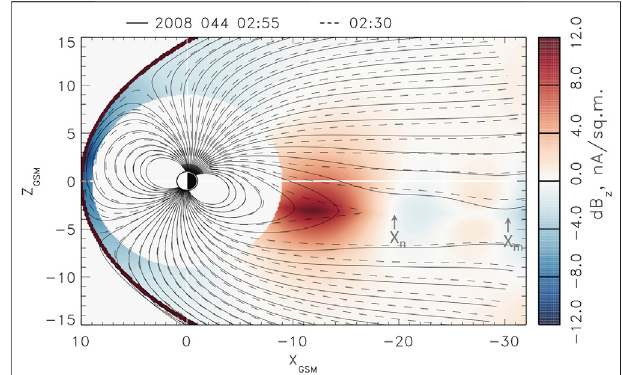
FIGURE 4 | Color-coded variations of the z-component of the magnetic fi eld between moments t B z ( t 0 ) in the noon-midnight meridional plane with overplotted magnetic fi eld lines in the format similar to Figure 3 in case of the 13 February 2008